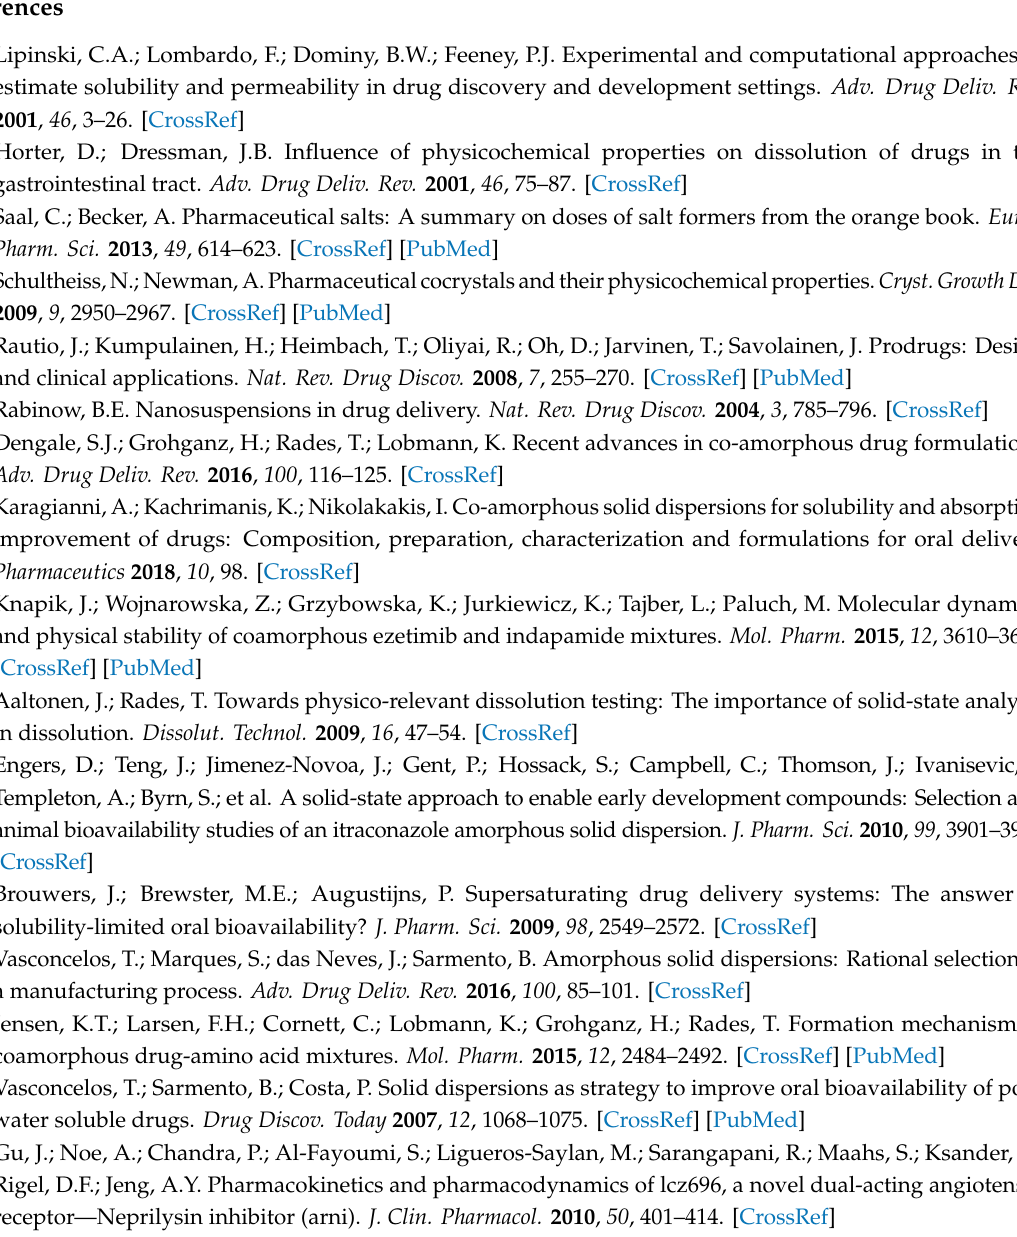
Figure S1: The whole FTIR patterns of spray-dried samples, Figure S2: Dissolution profiles of spray-dried samples under sink conditions. ( n = 3), Figure S3: DSC thermograms for co-amorphous LM SDs. Ramp 20 ◦ C / min to 160.00 ◦ C (blue curve); Isothermal 1.0 min; Ramp 20 ◦ C / min to − 20.00 ◦ C (red curve); Isothermal 1.0 min; Ramp 20 ◦ C / min to 160.00 ◦ C (purple curve), Figure S4: PLM images of spray-dried samples collected at 5 min and 4 h during D / P study. Figure S5: PXRD patterns of solid residues after D / P study. Figure S6: Liquid chromatogram of spray-dried samples (a–c) under room temperature for 6 months, (d–f) under 40 ◦ C / 75% RH for 1